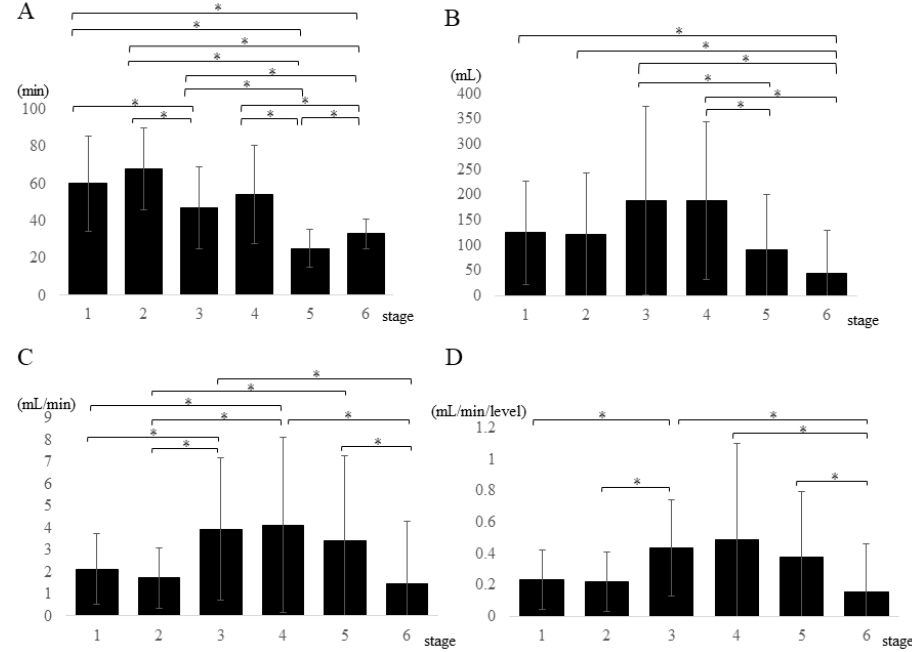
Figure 3. Multiple-comparison analysis of ( A ) procedure time, ( B ) blood loss, ( C ) bleeding speed, and ( D ) bleeding speed per fused level among the six stages are shown. * p < 0.05. Table 3. Multiple-Linear-Regression Analysis for Total Blood Loss. ( A ) Including only preoperative data. ( B ) Including preoperative data and blood loss during the exposure stage. Unstandardized Standardized t